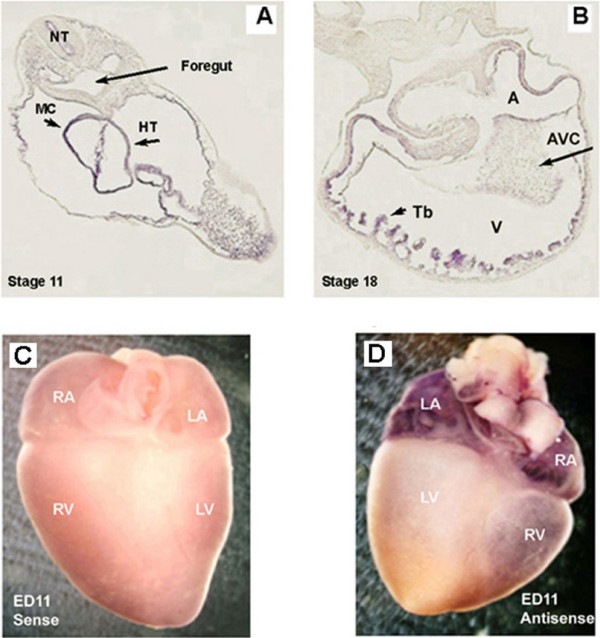
In situ hybridization of chicken TASK-1 expression in developing chick heart. A: in situ hybridization of S11 chick embryos. TASK-1 was ubiquitously expressed in S11 embryonic heart. B: In situ hybridization of TASK-1 in S18 chick embryonic heart. TASK-1 was expressed in the both the atrium and ventricle. However, expression appeared greatest in the trabeculae of the S18 heart. Whole mount In situ hybridization of TASK-1 in ED11 chick heart shown in C and D. C: a control in situ hybridization with sense RNA probe staining. No detectable purple staining was observed. D: TASK-1 was strongly expressed in the both right and left atria and lightly expressed in the ventricle in ED11 chick heart. Abbreviations are: heart (HT), myocardium (MC), neural tube (NT), trabeculae (Tb), atrial-ventricular cushion (AVC), right atrium (RA), left atria (LA), right ventricle (RV) and left ventricle (LV).